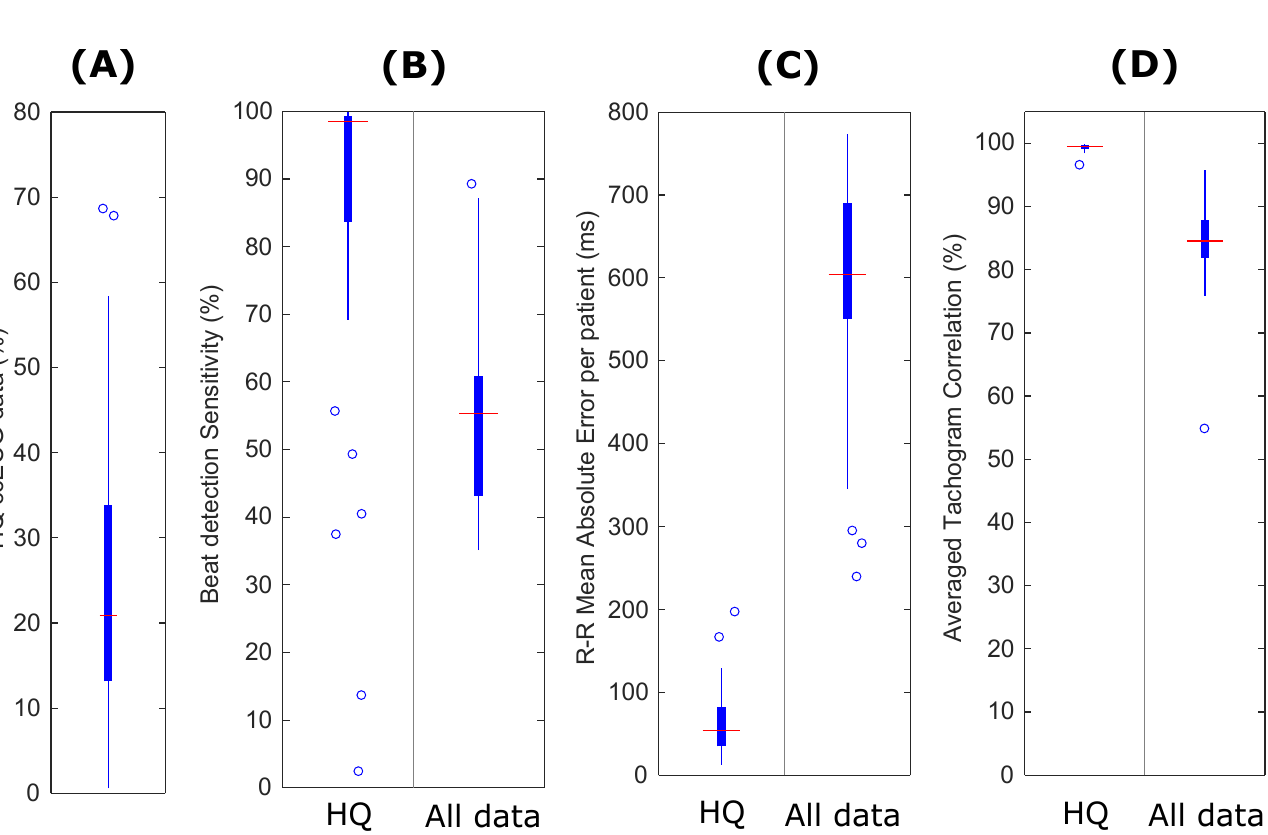
Figure 4. Results of ccECG evaluation when applying SQIs (high-quality data, HQ) and comparing against gold standard PSG ECG. The SQI algorithms are able to extract 21% of high-quality data for feature extraction. This is lower than in the previous data collection [10], presumably due to degradation of the ECG electrodes over time by usage and cleaning of the mattress. ( A ) Percentage of data used per patient after SQI processing. ( B ) Beat detection sensitivity before and after applying SQIs. ( C ) R-R Mean Absolute Error before and after applying SQIs. ( D ) Averaged tachogram correlation with gold standard before and after applying